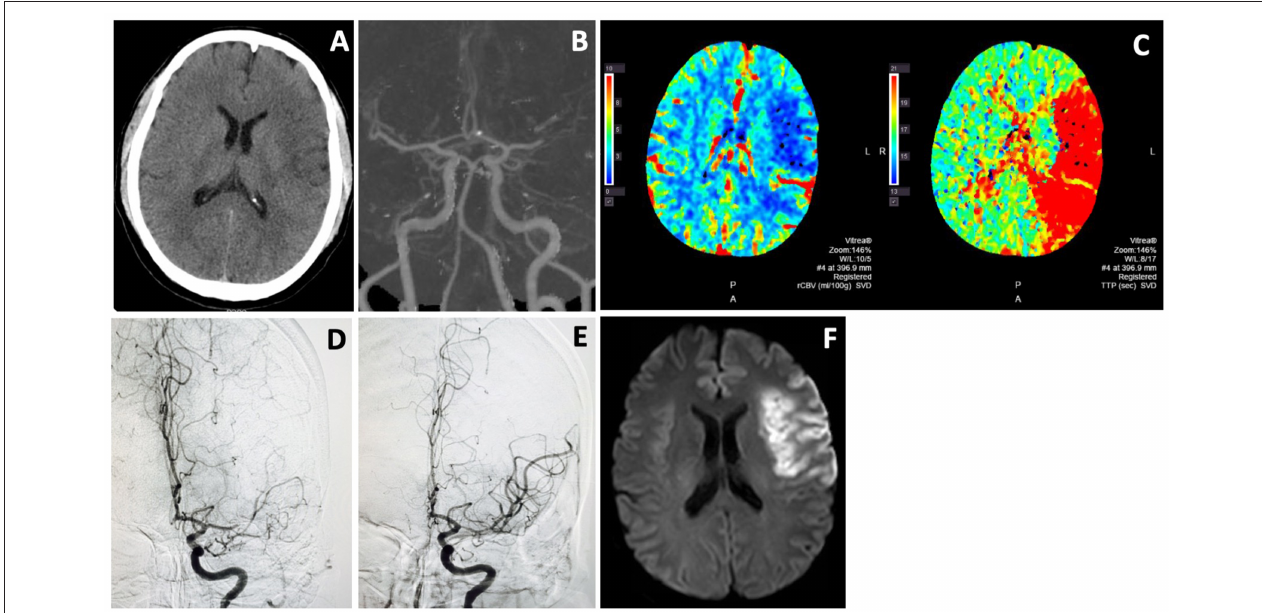
FIGURE 2 | Endovascular thrombectomy for wake-up stroke. A 44 years old man woke up with right sided weakness and global aphasia. Last known well was 8 p.m. the night before. NIHSS score was 15. Non-contrast CT showed subtle left frontal hypodensity with ASPECTS of 8 (A) . CTA showed L MCA M1 occlusion (B) and CTP revealed a large ischemic penumbra (C) . He underwent thrombectomy with excellent MCA recanalization (D,E) . Follow-up MRI (F) showed an infarct in the left frontal region that was similar in size to the hypodense area on non-contrast CT and infarct core on CTP. He recovered well with only mild expressive aphasia at 3 month.